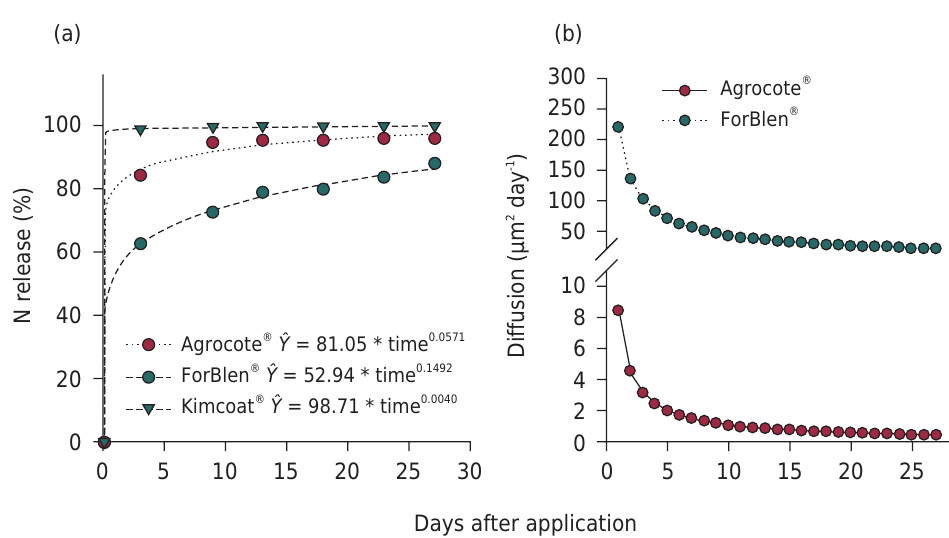
Figure 2. Nitrogen released (a) and N diffusion (b) through the coating of the PCUs over time.